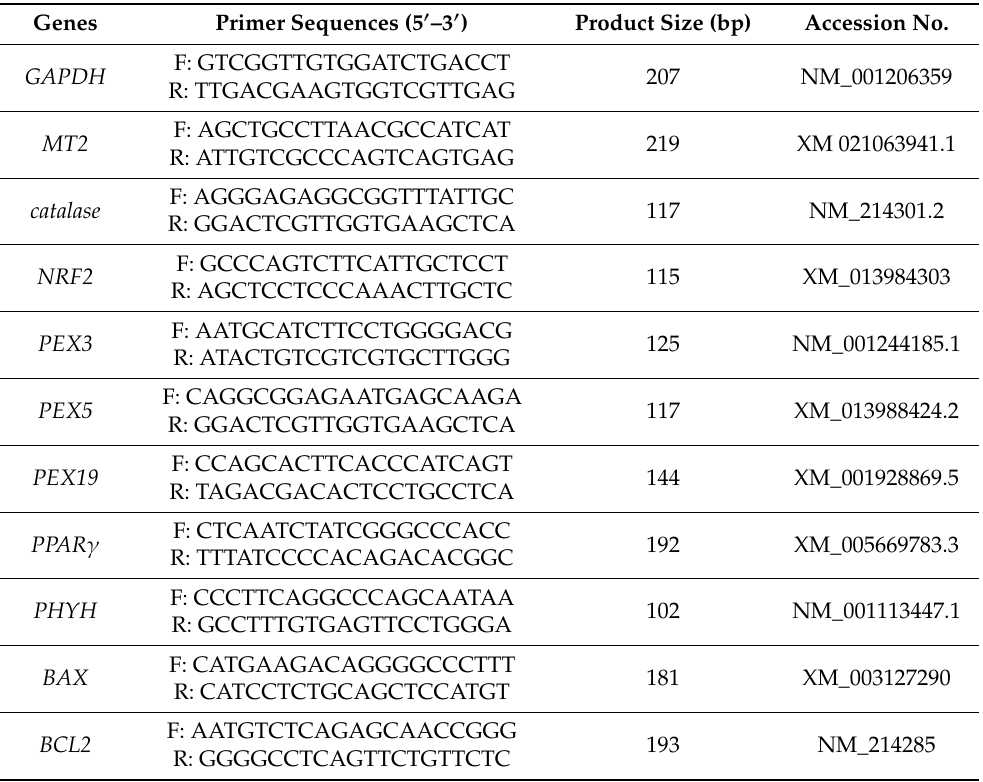
Table 1. Sequence-specific primers used for quantification of di ff erential expressed